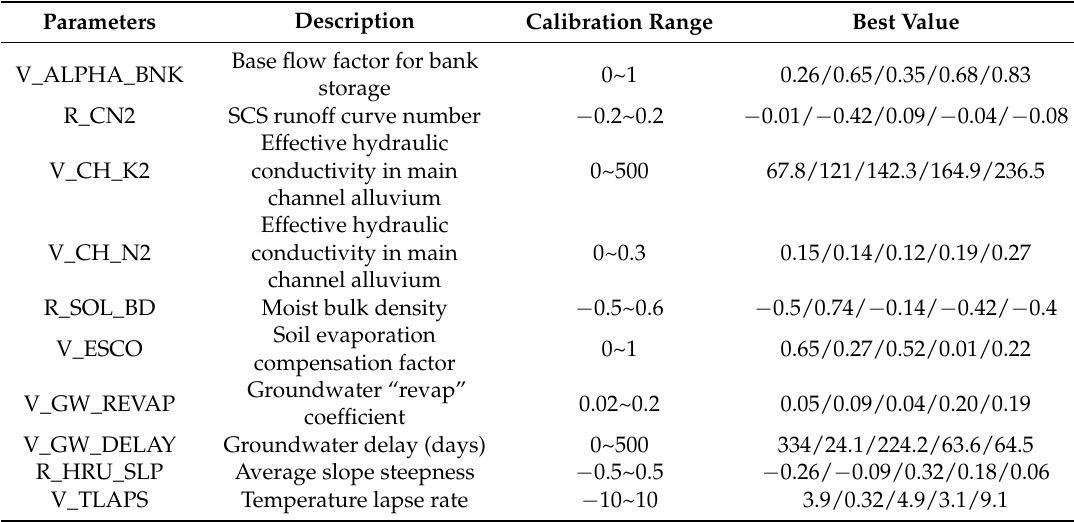
Table 3. Initial ranges of 10 more sensitive calibrated parameters and their final optimal values for five precipitation inputs (Gauge, AgMERRA, MSWEP, PERSIANN-CDR, and